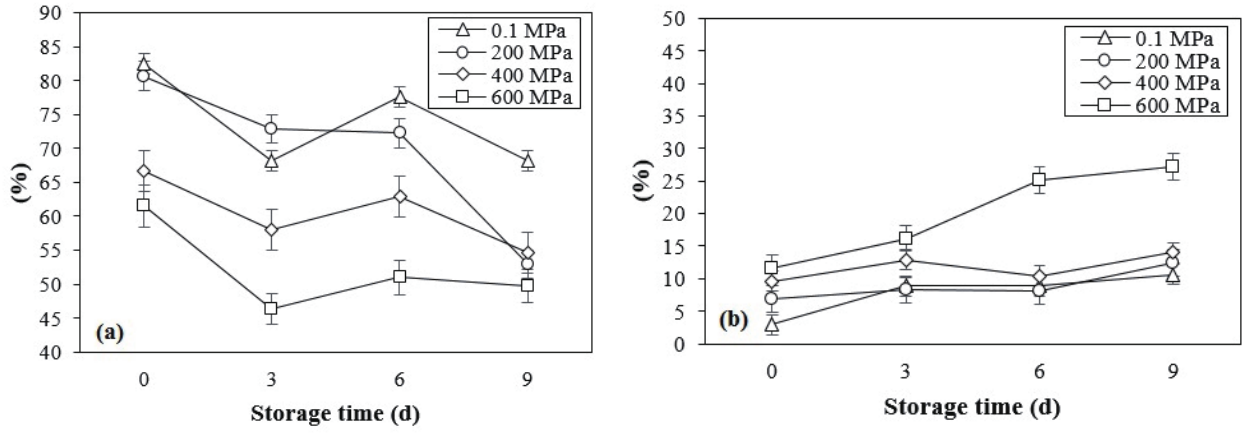
Figure 1. Changes in oxymyoglobin (a) and metmyoglobin (b) relative proportion of DFD strip loin subjected with different levels of pressure during refrigerated storage under vacuum. These data are presented as mean±standard deviation. DFD,